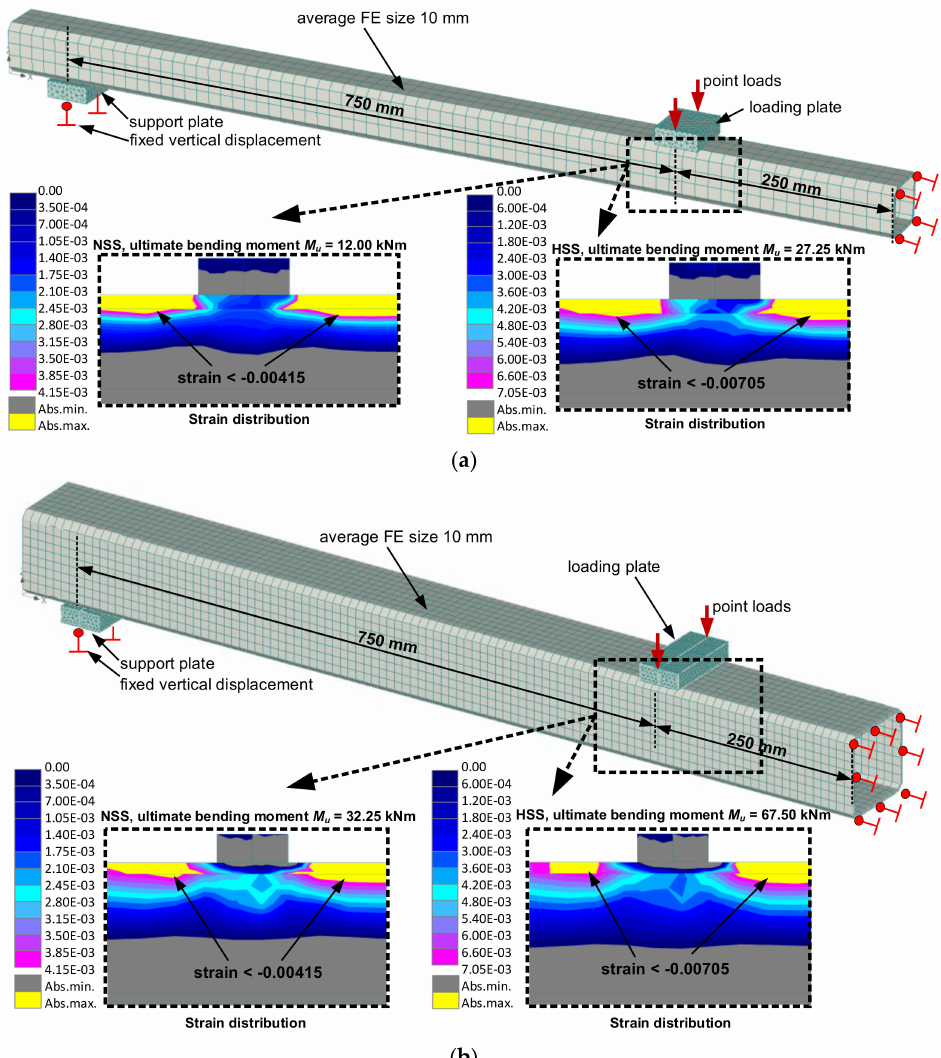
Figure 8. Finite element (FE) model and numerical simulation results (strain distribution) of the beams with di ff erent size of the cross-section: ( a ) 60 × 60 × 4 mm; ( b ) 100 × 100 × 4